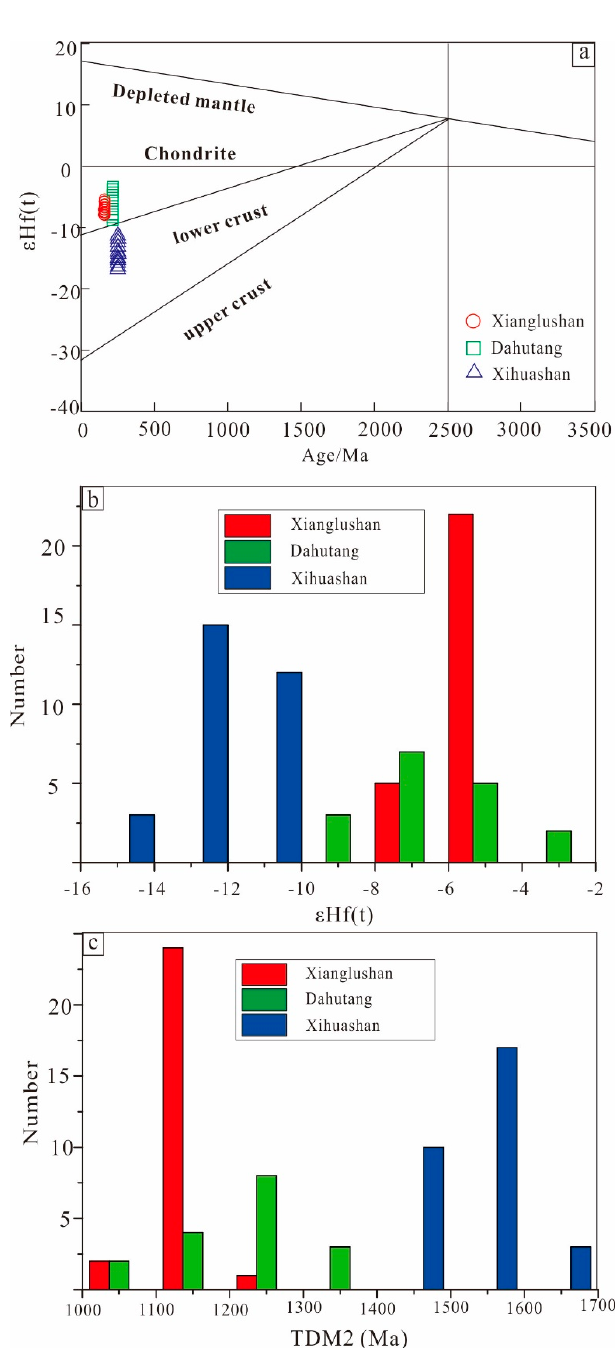
Figure 5. ( a ) ε Hf(t) vs. U-Pb age diagram and histograms of ( b ) ε Hf(t) value; ( c ) Two-stage model ages (TDM2).